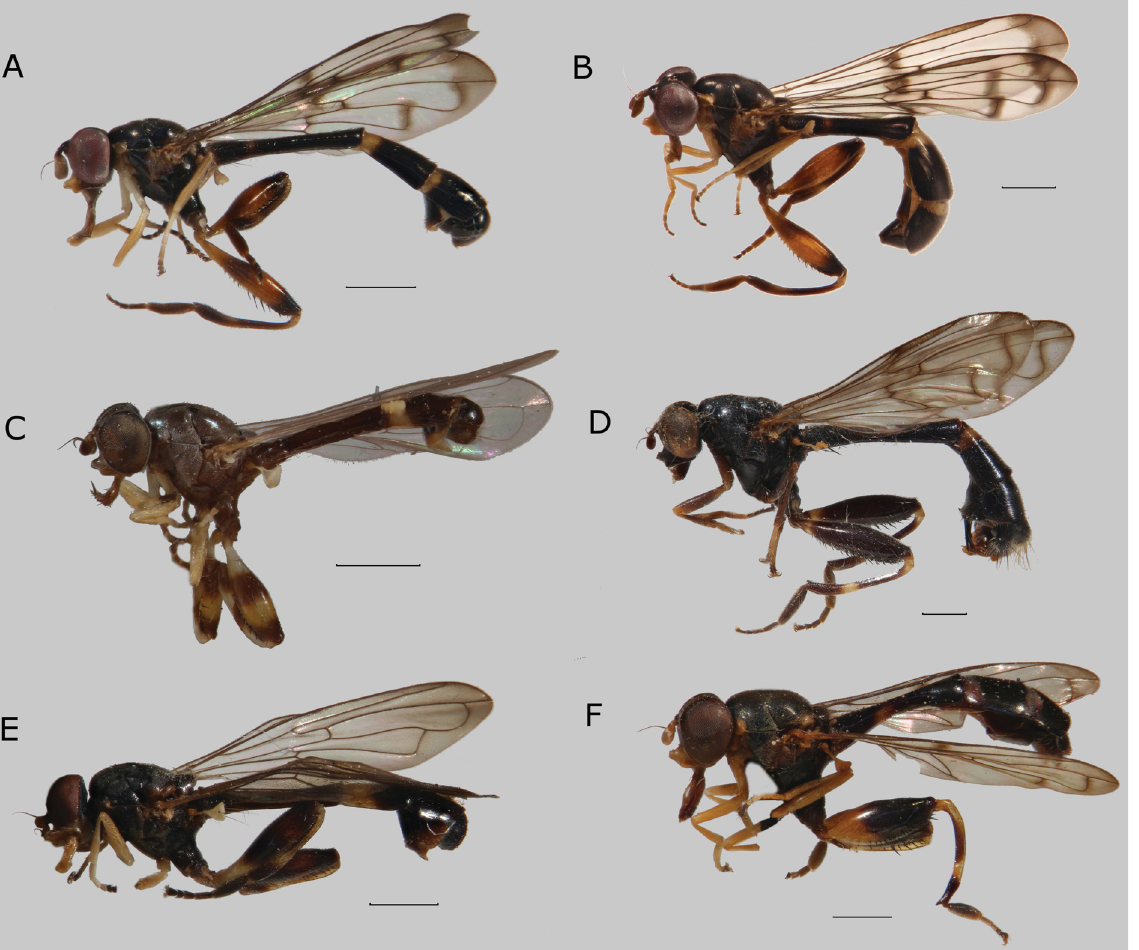
Fig. 67. Habitus, lateral vi ew. A . Sphegina (Asiosphegina) orientalis Kertész, 1914, ♂ ,